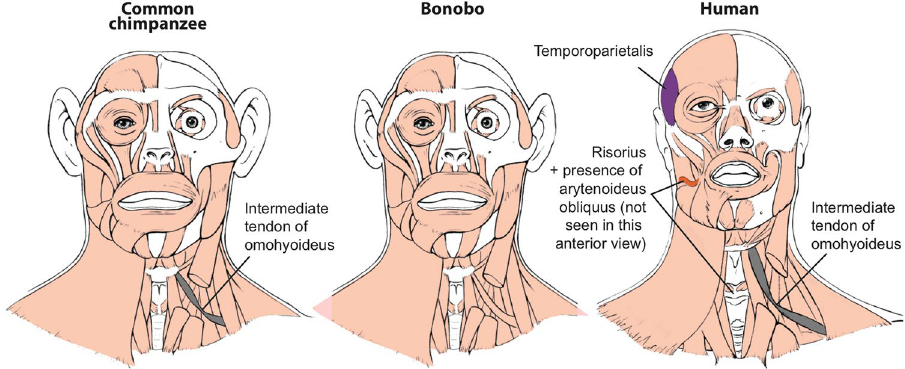
Figure 1. Differences between head muscles of common chimpanzees, bonobos and modern humans. There are no major consistent differences concerning the presence/absence of muscles in adult common chimpanzees (left) and bonobos (center), the only minor difference (shown in grey in the common chimpanzee scheme) being that the omohyoideus has no intermediate tendon in bonobos, contrary to common chimpanzees (and modern humans). In contrast, there are many differences between bonobos and modern humans (right) concerning the presence/absence of muscles in the normal phenotype (shown in colors and/or with labels in the human scheme). See text for more